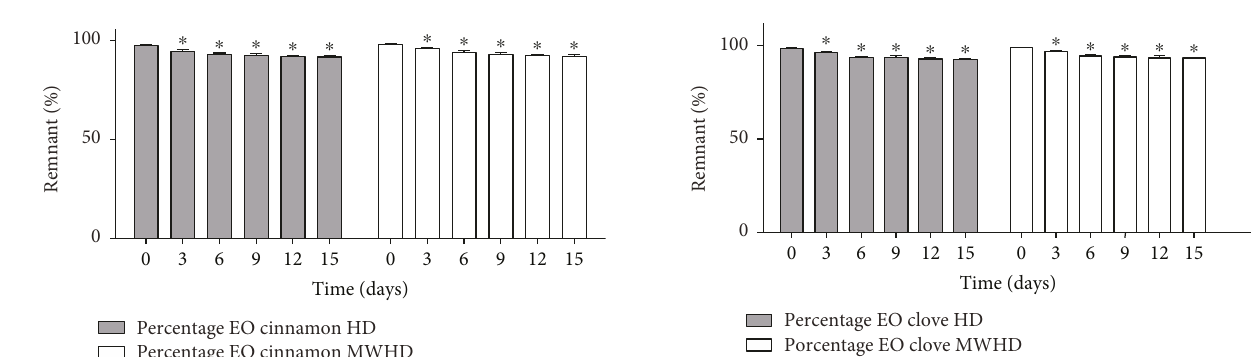
Figure 7: Remnant percentage of cinnamon essential oil in a 15- day aging, compared to the original composition. ∗ Signi fi cant di ff erences compared to day 0 p < 0 05